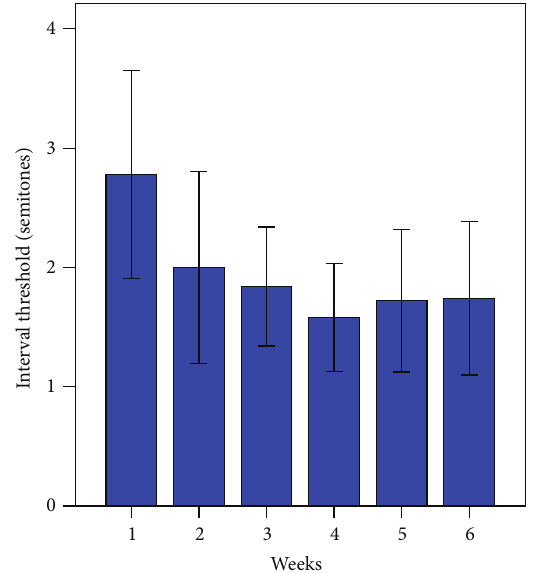
Figure 3: Week-to-week interval threshold scores for the Melodic Contour Training Program (Interval group). Error bars indicate 1 standard